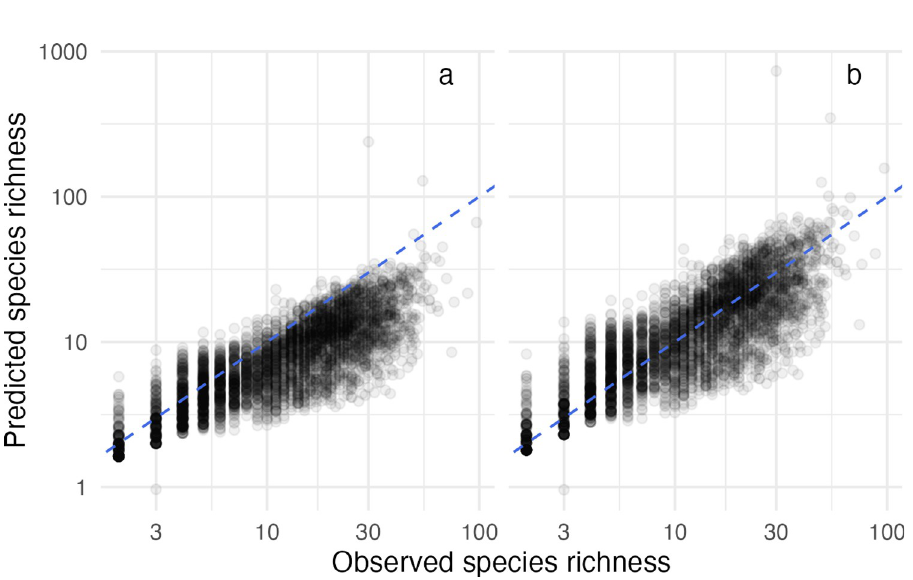
Fig 2. Relationship between the observed species richness and model predictions in 4,375 animal communities. With the raw predictions from a geometric-series model (a) and after applying an empirical correction factor (b). Dashed line is the 1:1